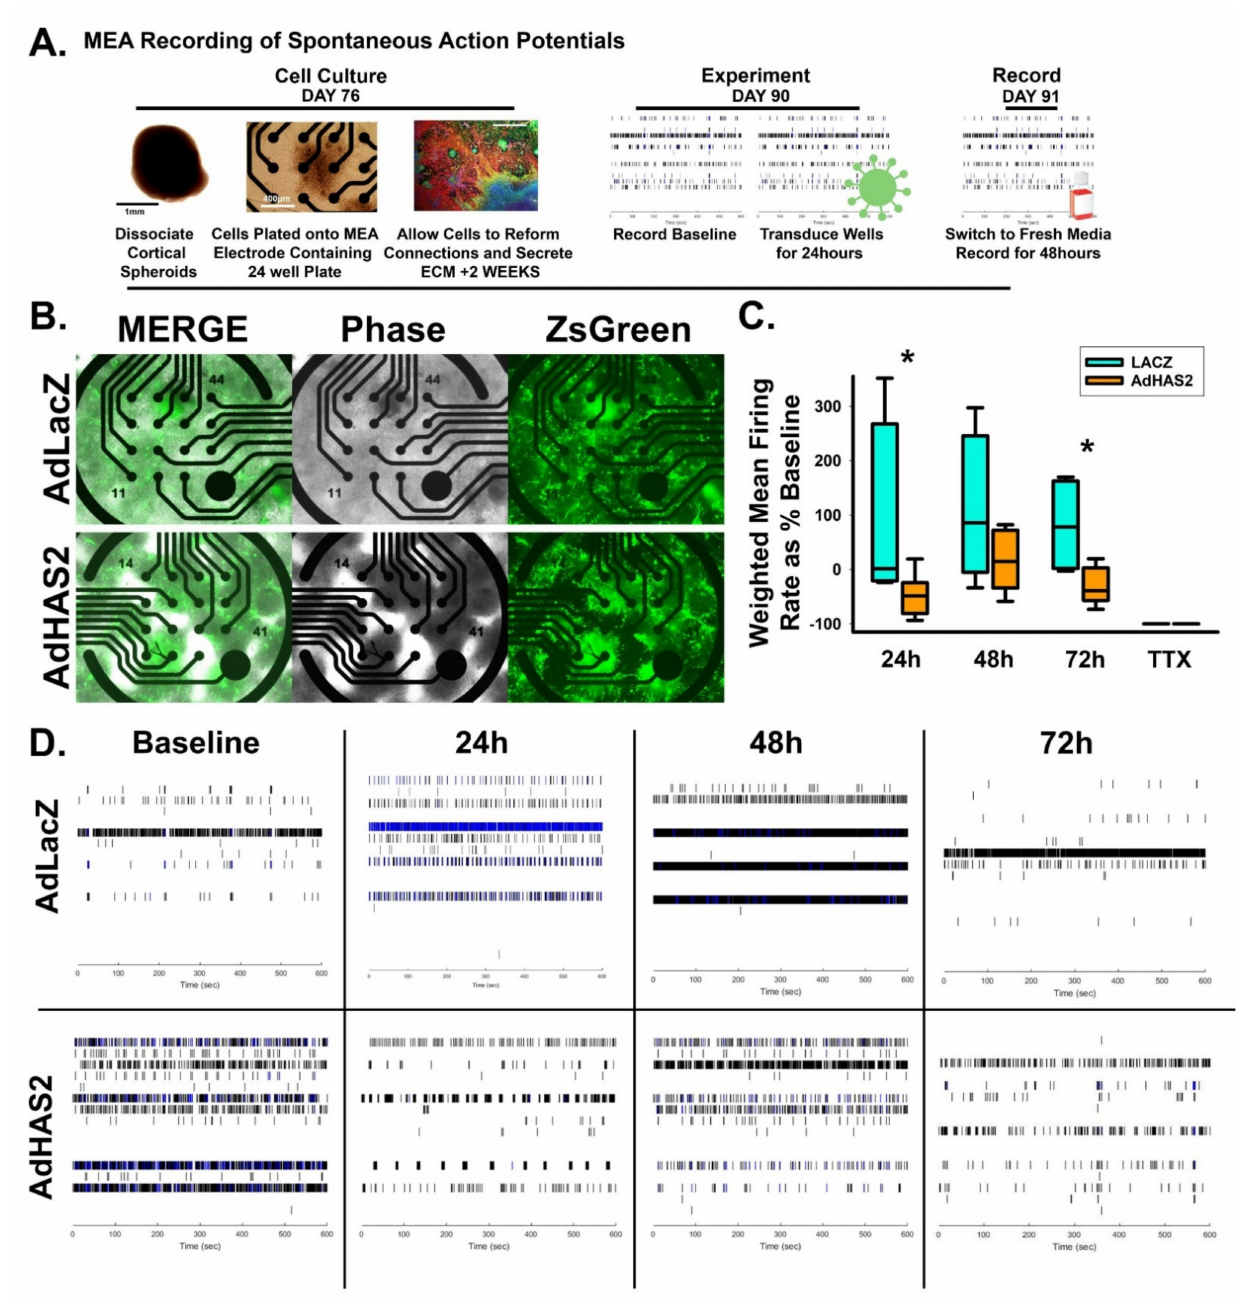
Figure 5. HAS2 suppresses excitability of developing neural networks. ( A ) Workflow of multielectrode array experiments for detection of action potentials propagation in neural networks. ( B ) Representative images of successful viral transduction on MEA plates as indicated by viral expression of ZsGreen in dissociated spheroid transduced with adenovirus constructs for control LacZ (AdZsGrnLacZ) and HAS (AdZsGrnHAS2) expression. ( C ) Quantification of weighted mean firing rate of spontaneous action potentials in HAS2 and LacZ-expressing dissociated spheroids demonstrates that HAS2 suppresses excitability by significantly reducing the firing rate at 24 and 72 h post-transduction. Tetrodotoxin (TTX) was used to inhibit action potential propagation, demonstrating that the firing rate reflects action potentials. n = 6 wells of dissociated spheroids per treatment. Spheroids were derived from 3 separately grown and transduced spheroid sets. * p ≤ 0.05 ( D ) Representative raster plots of spontaneous action potential firing at 0 (baseline), 24, 48, and 72 h post-transduction for AdZsGrnLacZ and